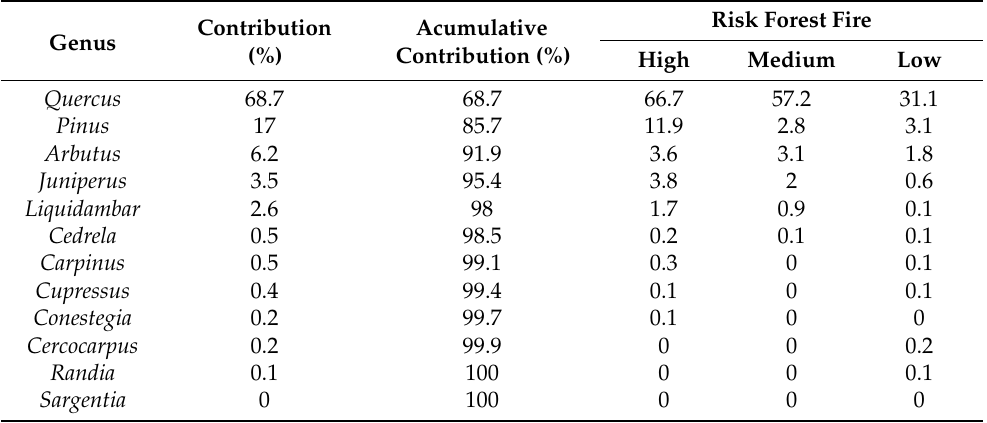
Table 5. Genus’s contribution.